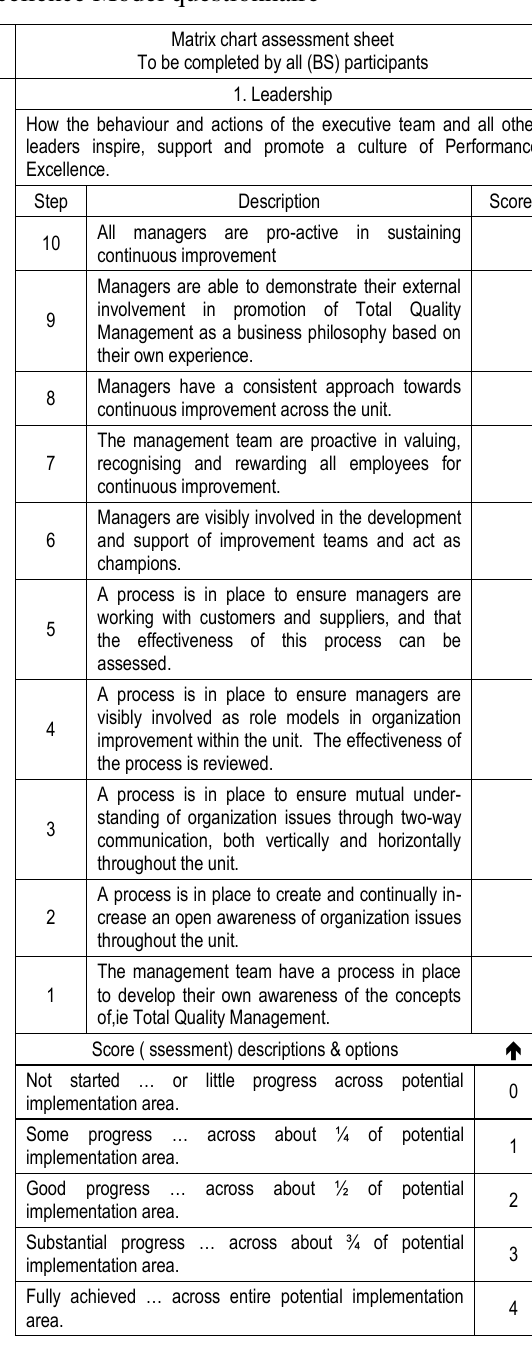
Table 1. Sample of South African Excellence Model